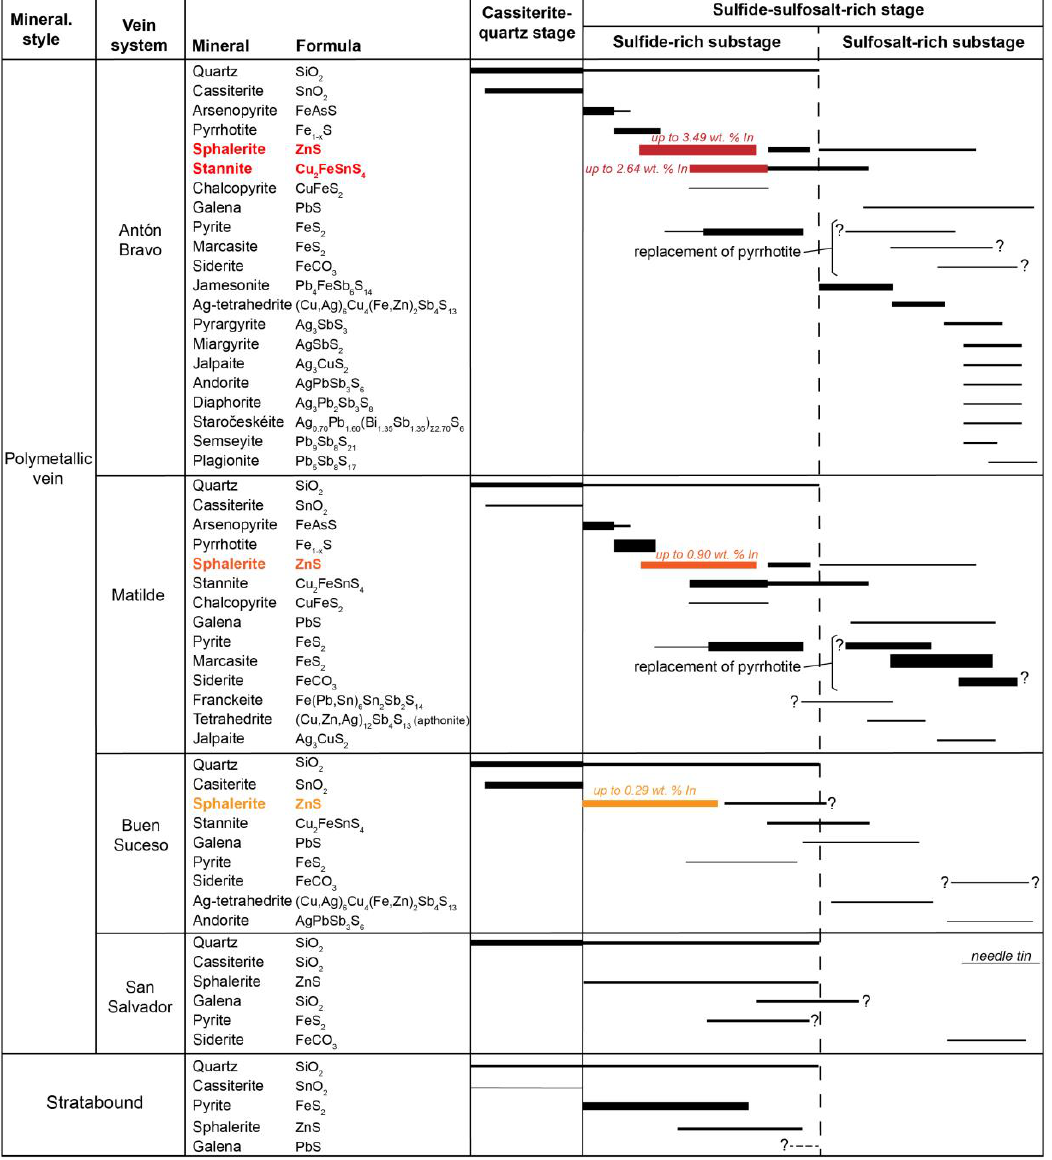
Figure 7. Paragenetic sequences deduced for hypogene mineralization in the Huari Huari district. The width of the bars approximates the relative abundance of the listed minerals. Location of the mineral phases or generations yielding highlighted concentrations of In, and the maximum concentration for this metal are indicated in color. The timing of crystallization shown in the paragenetic sequence is relative to observations made on each vein system and the stratiform mineralization; therefore, it does not necessarily indicate absolute timing.